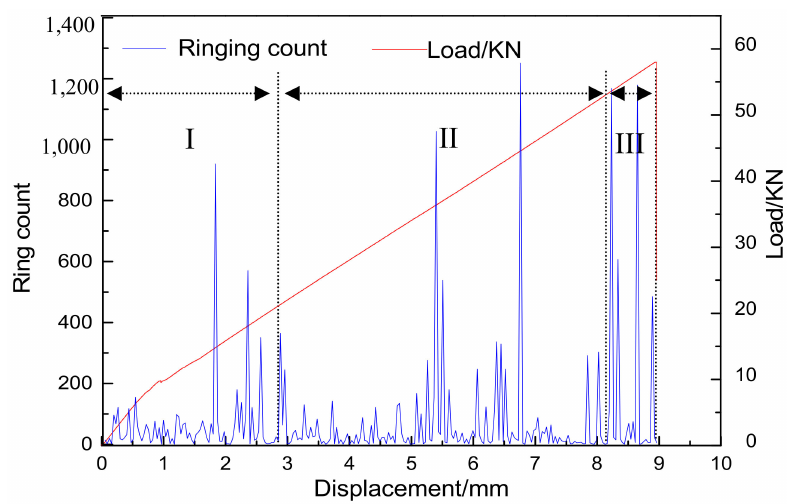
Figure 7. Change in the load–displacement curve corresponding with the AE signal ringing count parameter of specimen B-V1.